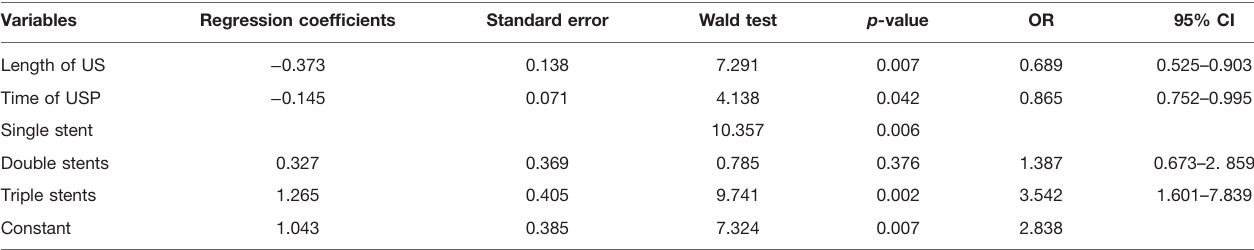
TABLE 4 | Risk factors related to the prognosis of patients at 12 months after stent removal using multivariate